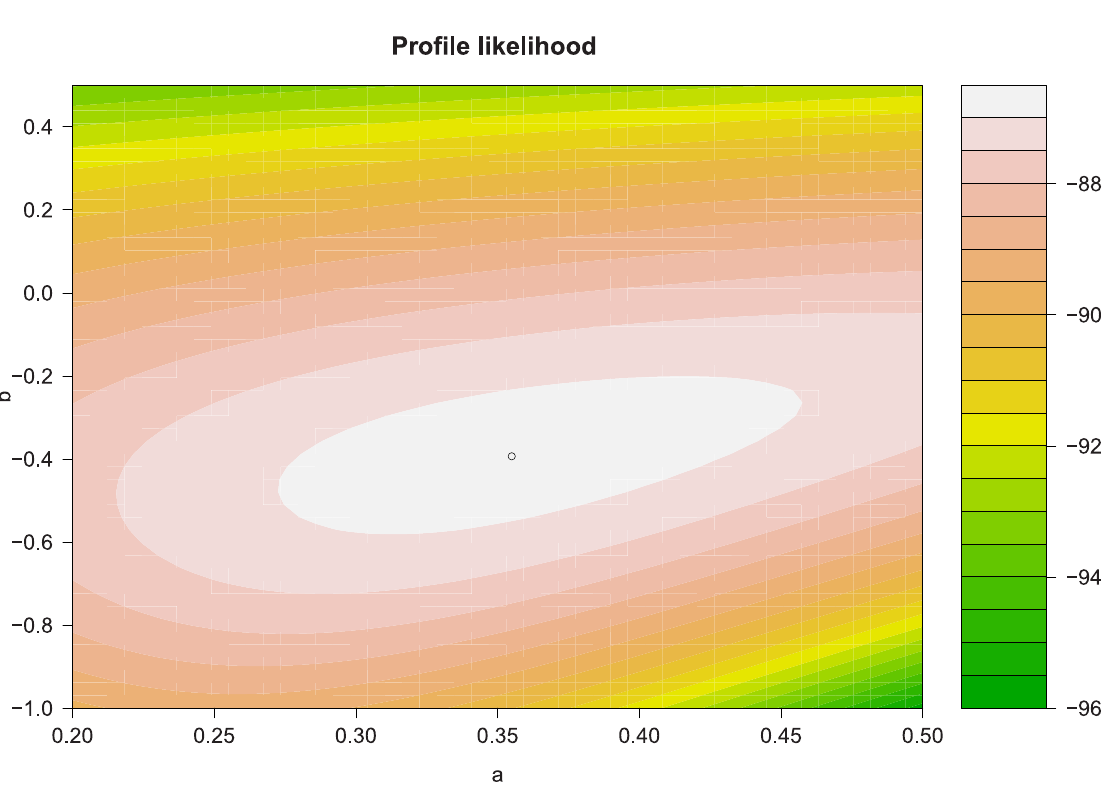
Fig 2. Constrained dependence parameter estimates ^ a on Prec > qu Prec , with qu Prec being the 90 th quantile of the conditioning variable Prec , correspond to the maximum of the profile likelihood surface using maize data of Eastern Africa.